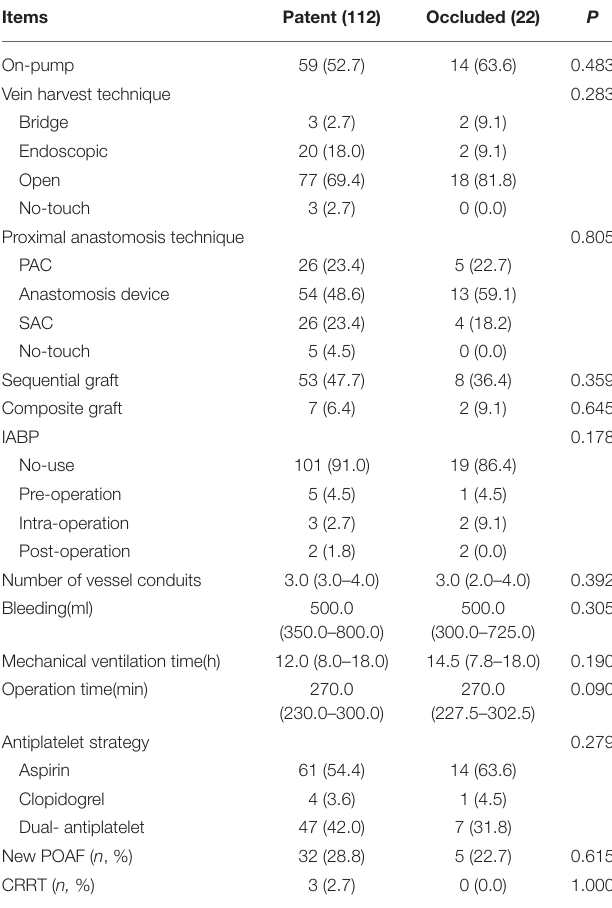
TABLE 2 | Baseline procedural characteristics of the patent group and the occluded